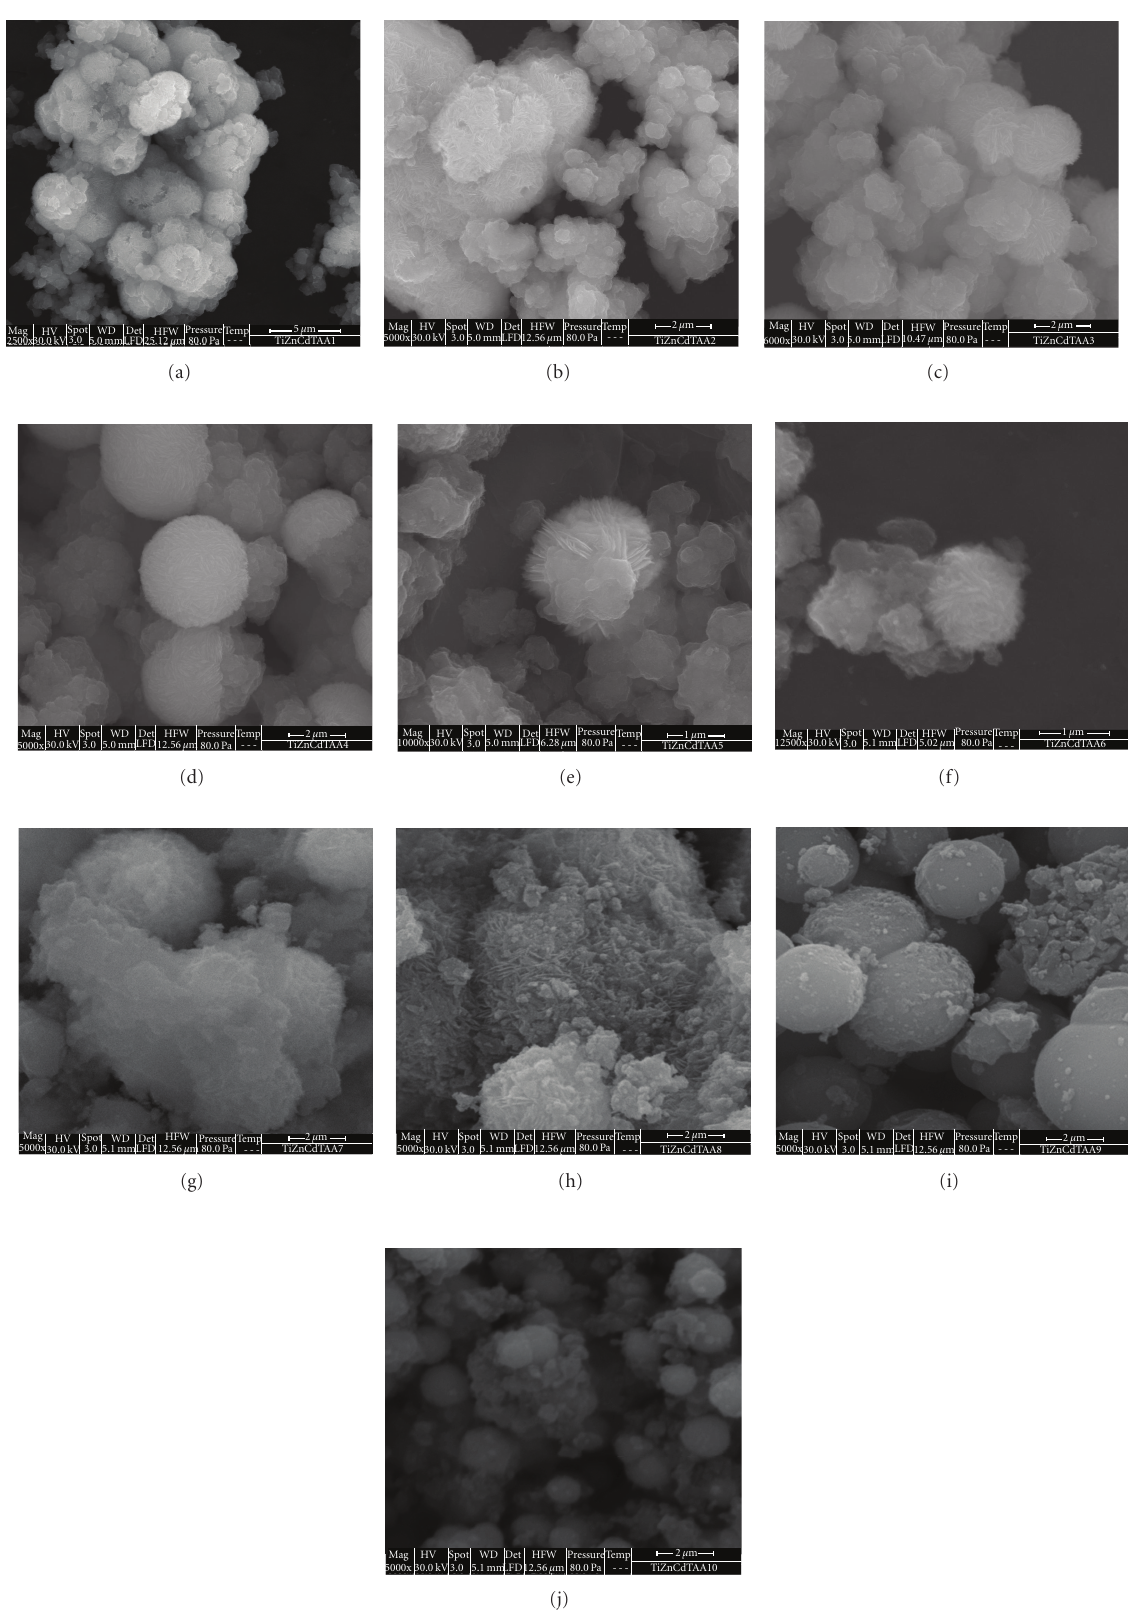
Figure 7: SEM images of sample (a) TiZnCd1, (b) TiZnCd2, (c) TiZnCd3, (d) TiZnCd4, (e) TiZnCd5, (f) TiZnCd6, (g) TiZnCd7, (h) TiZnCd8, (i) TiZnCd9, and (j)